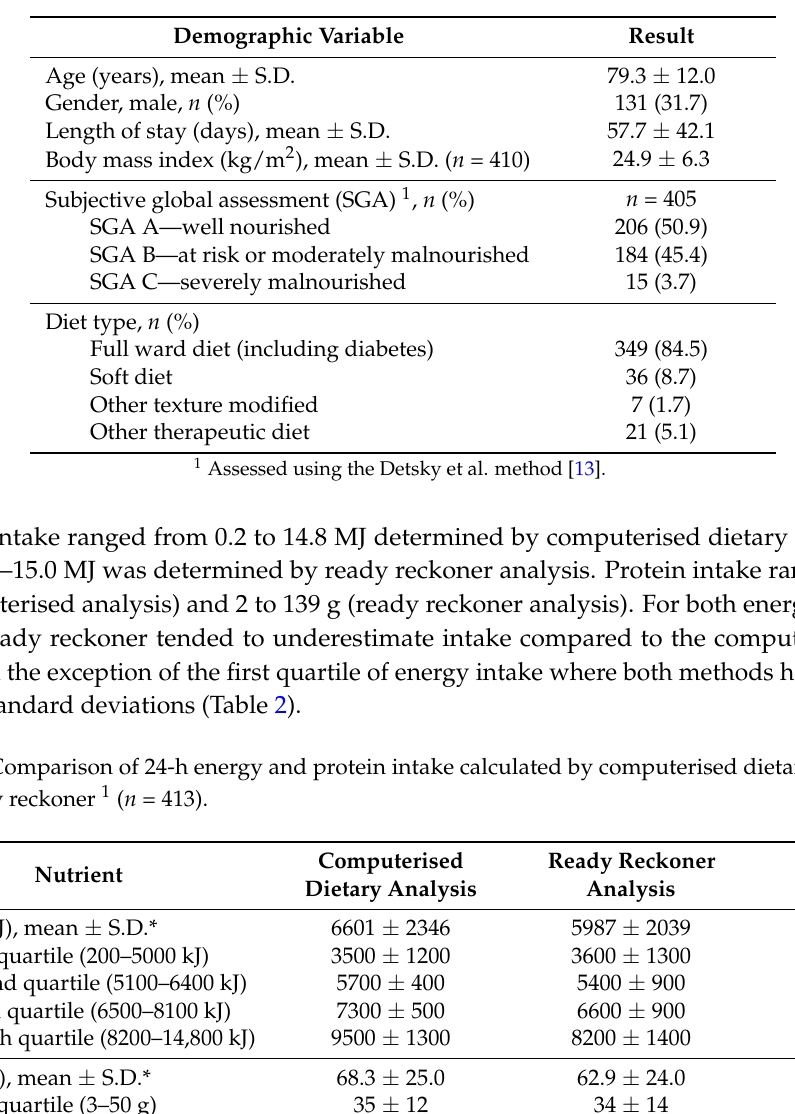
Table 1. Characteristics of participants who consumed food during the 24-h observation ( n = 413).